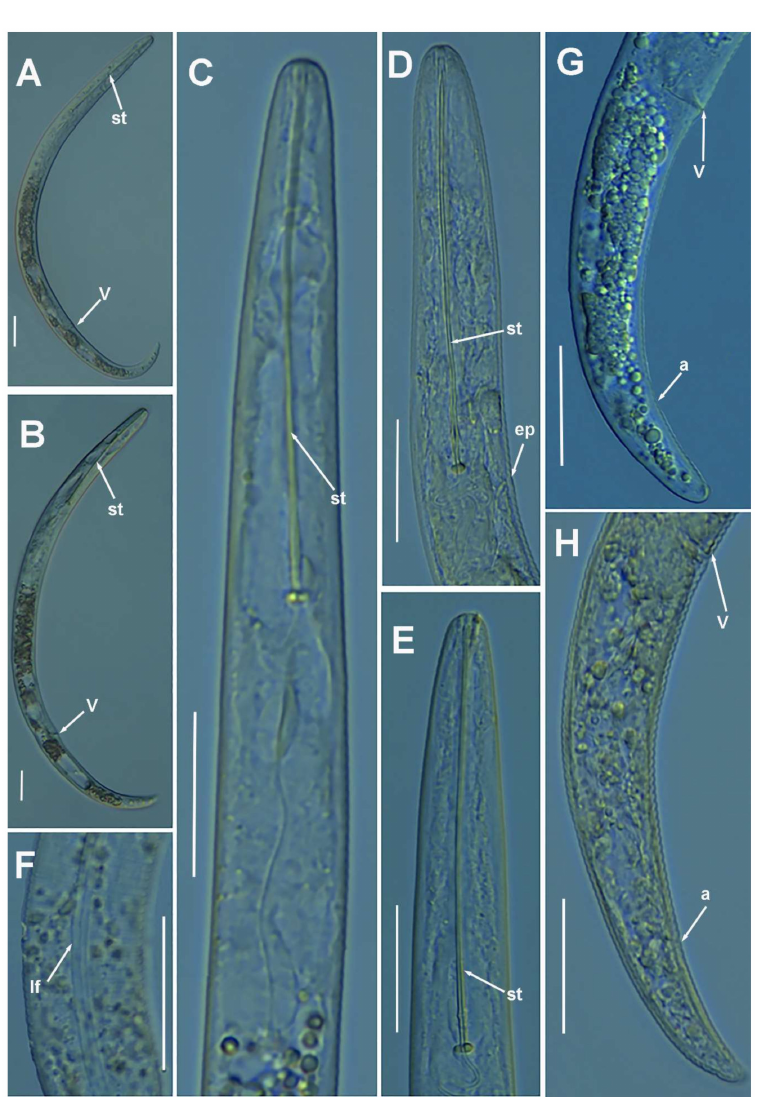
Figure 4. Light photomicrographs of Paratylenchus aciculus Brown, 1959. ( A , B ) Entire female with vulva arrowed; ( C ) female pharyngeal region; ( D , E ) female lip region; ( F ) detail of lateral field; ( G , H ) female posterior region with vulva and anus (arrowed). Scale bars ( A – H = 20 µ m). (Abbrevia- tions: a = anus; ep = excretory pore; lf = lateral field; st = stylet; V =